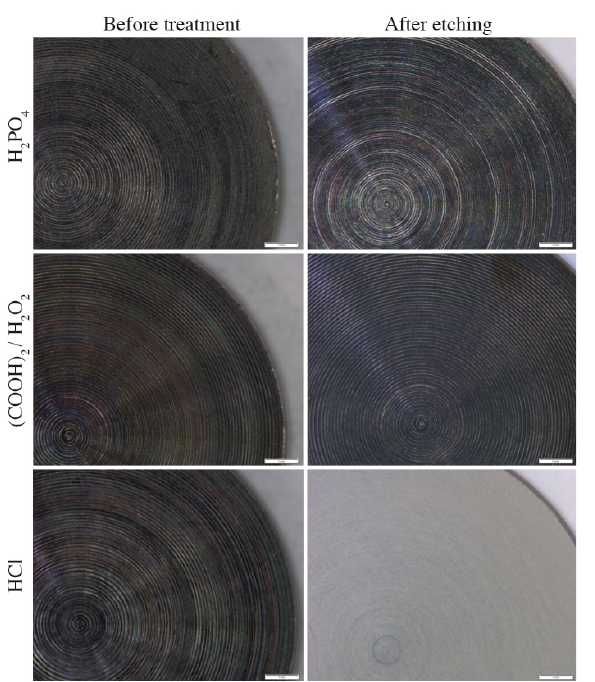
Figure 1. Stereo microscopic images of titanium discs before and after etching in H PO , in the compound 3 4 of (COOH) 2H O and H O and in 30% HCl. 2 × 2 2 2